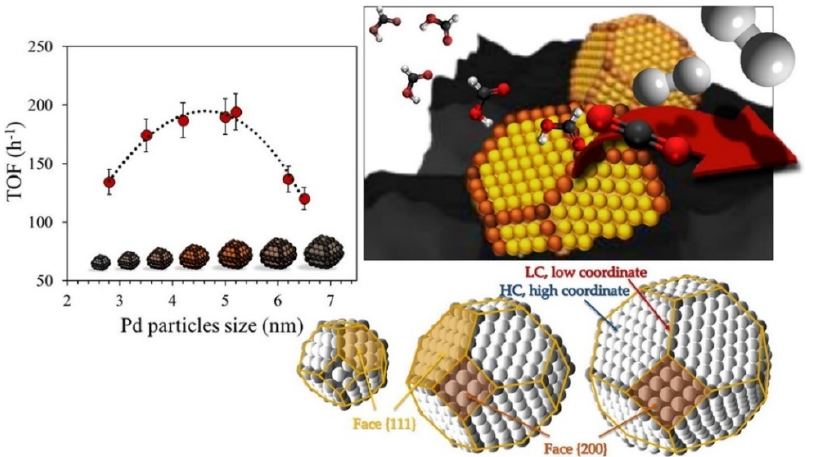
Figure 8. Illustration of structure-sensitivity character of formic acid dehydrogenation over Pd nanoparticles dispersed on active carbon as support. Adapted from reference [168].